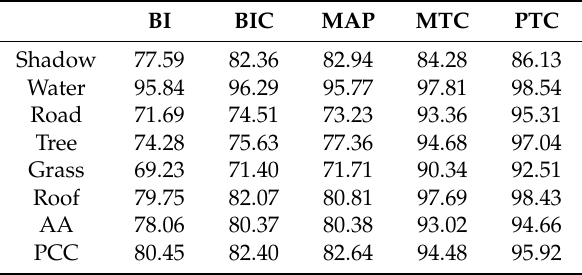
Table 3. Accuracy (%) of five methods in experiment 2 ( S =